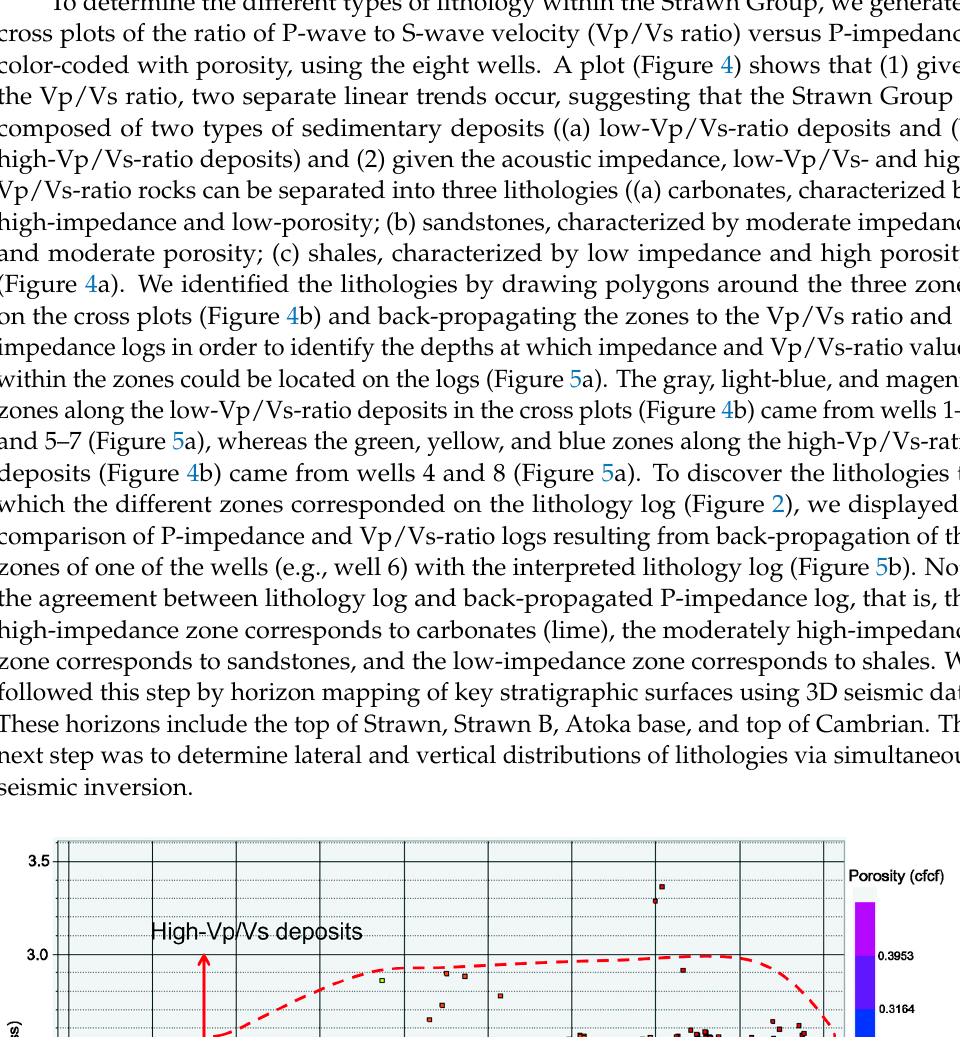
Figure 3. Database map showing well locations and lines of cross sections discussed in the text. Note: Red, black, and blue colors are used to identify different line of cross sections where lines are